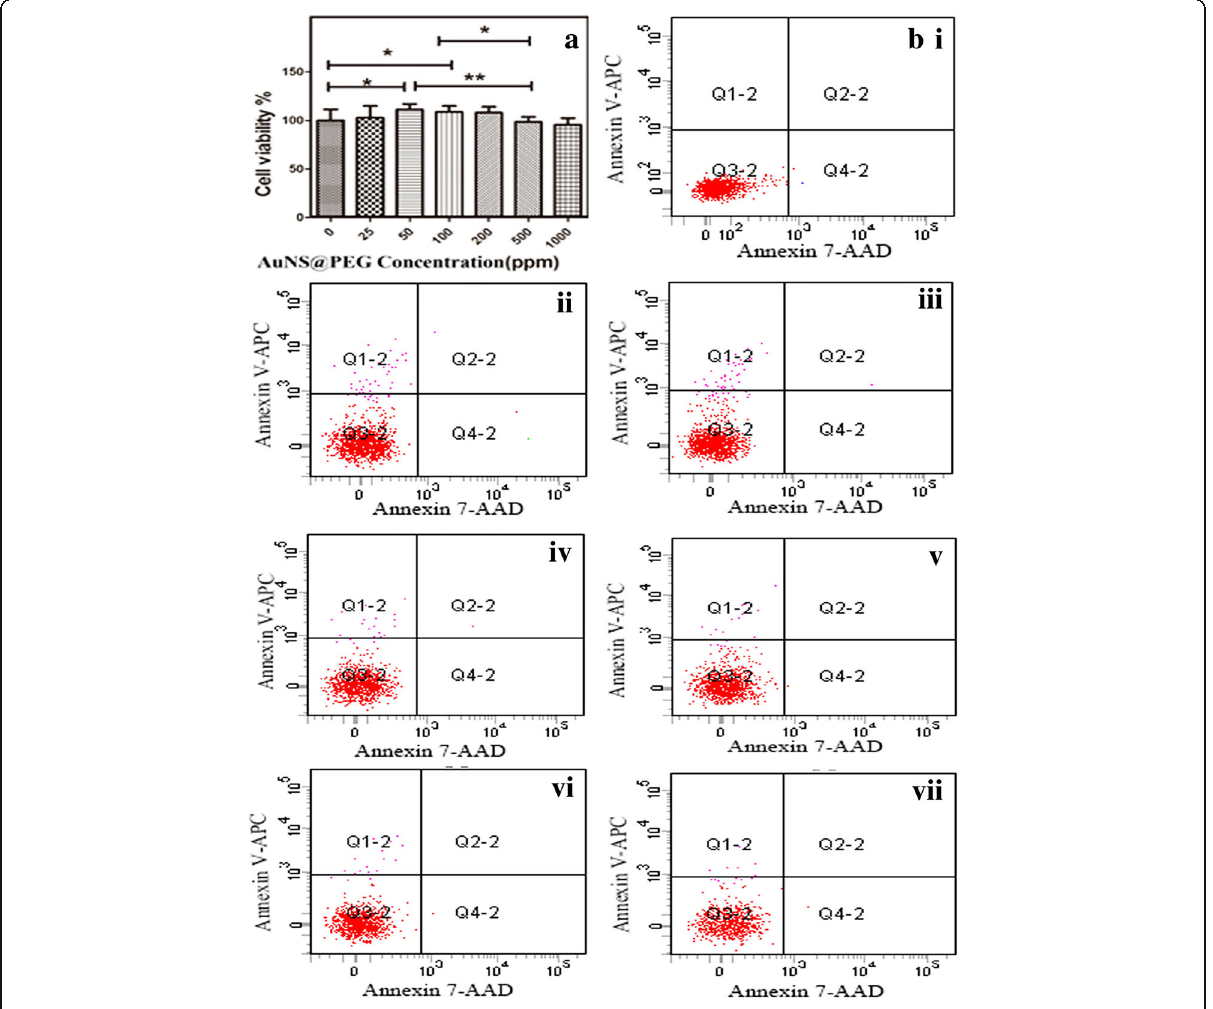
Fig. 3 Cell viability of neuroglia incubated with different concentrations of AuNS@PEG nanoparticles for 24 h ( a ); the apoptosis of cells induced by AuNS@PEG nanoparticles is shown by flow cytometry: control ( bi ), 25 ppm ( ii ), 50 ppm ( iii ), 100 ppm ( iv ), 200 ppm ( v ), 500 ppm ( vi ), and 1000 ppm ( vii